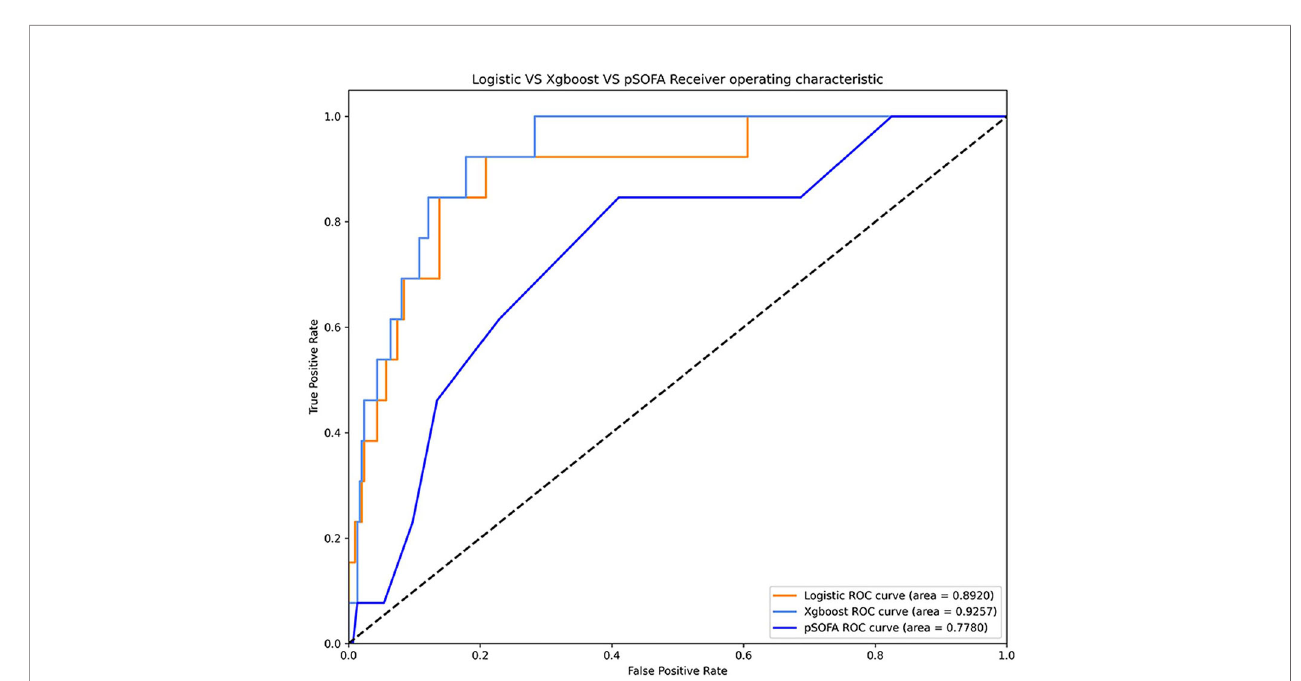
FIGURE 4 | ROC curve of XGBoost model, logistic regression model, and pSOFA to predict septic